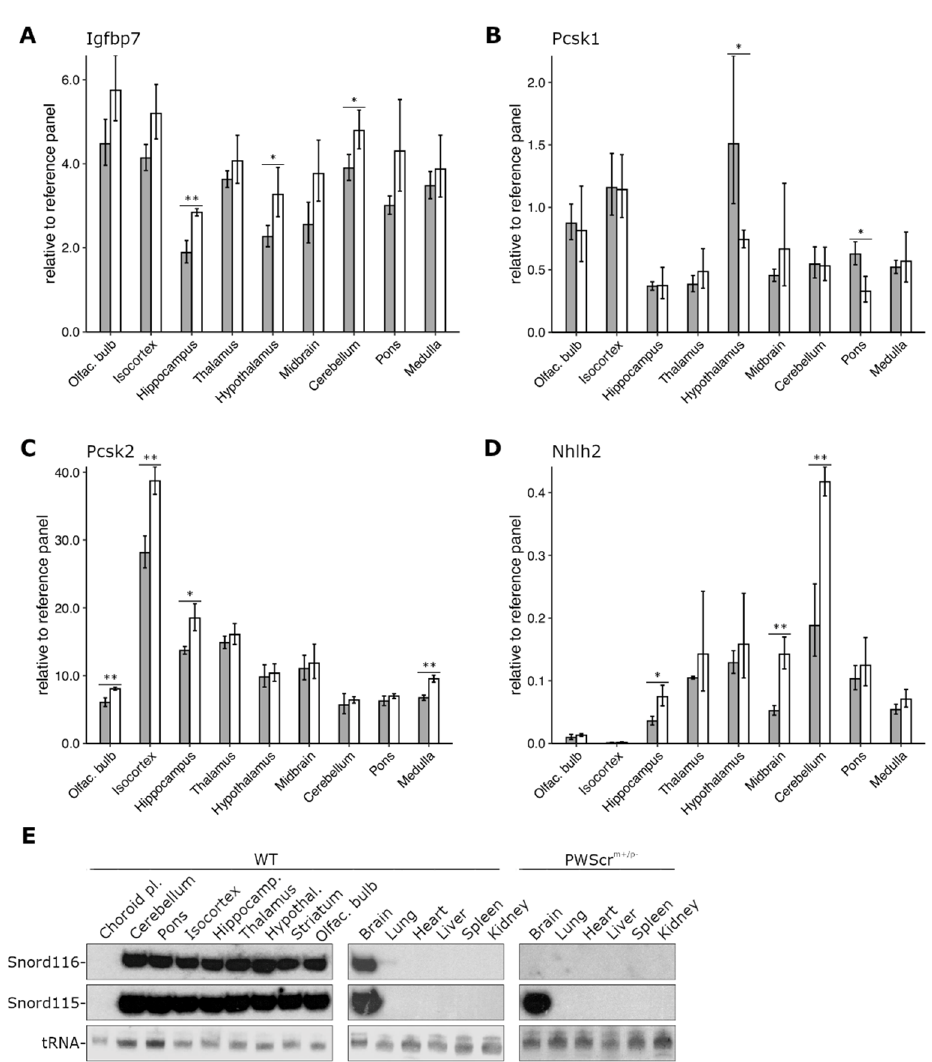
Figure 3. Expression analysis of Pcsk1 , Pcsk2 , Igfbp7 and Nhlh2 . ( A ) Comparative expression analysis of Igfbp7 , ( B ) Pcsk1 , ( C ) Pcsk2 , and ( D ) Nhlh2 genes relative to reference gene panel in nine brain regions of male mice P28 (WT in gray, PWScr m+/p − in white). Mean ± SD of three biological replicates (six for WT hypothalamus); * p ≤ 0.05, ** p ≤ 0.01, unpaired two-samples t -test. ( E ) Northern blot hybridization analysis of Snord116 and Snord115 expression in brain areas and tissues of WT mice (left and middle panels, respectively); and PWScr m+/p − (right panel) animals. As a loading control, tRNAs (negative image of an ethidium bromide-stained gel) is shown at the bottom. 2.4. Lack of Snord116 Influences Abundance but Not Splicing of Nlgn3 mRNA In